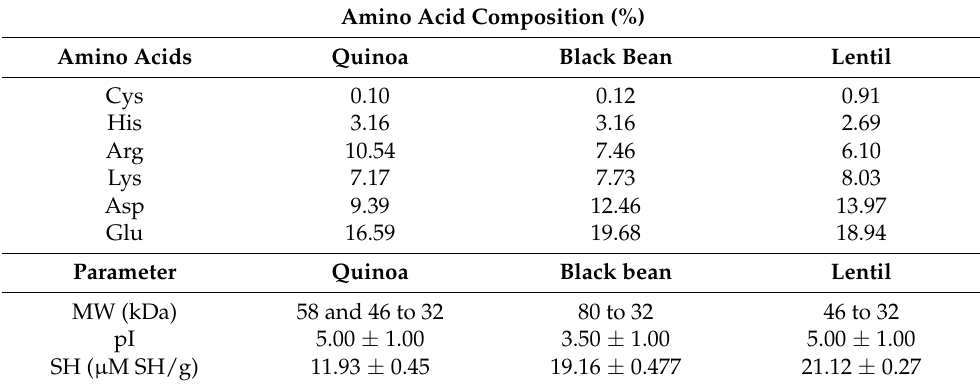
Table 1. Characterization of protein isolates obtained from quinoa, black beans, and